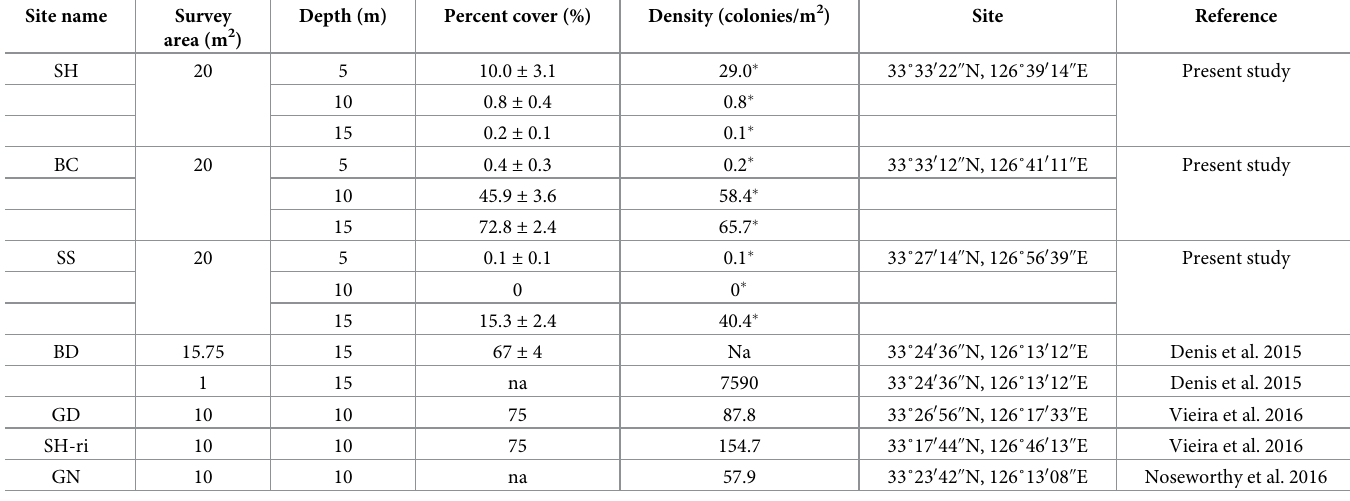
Table 1. Summary of the percentage cover and density of A . japonica reported from sites in Jeju Island, Korea (see Fig 1 legend for the explanation of site names). Site name Survey area (m 2